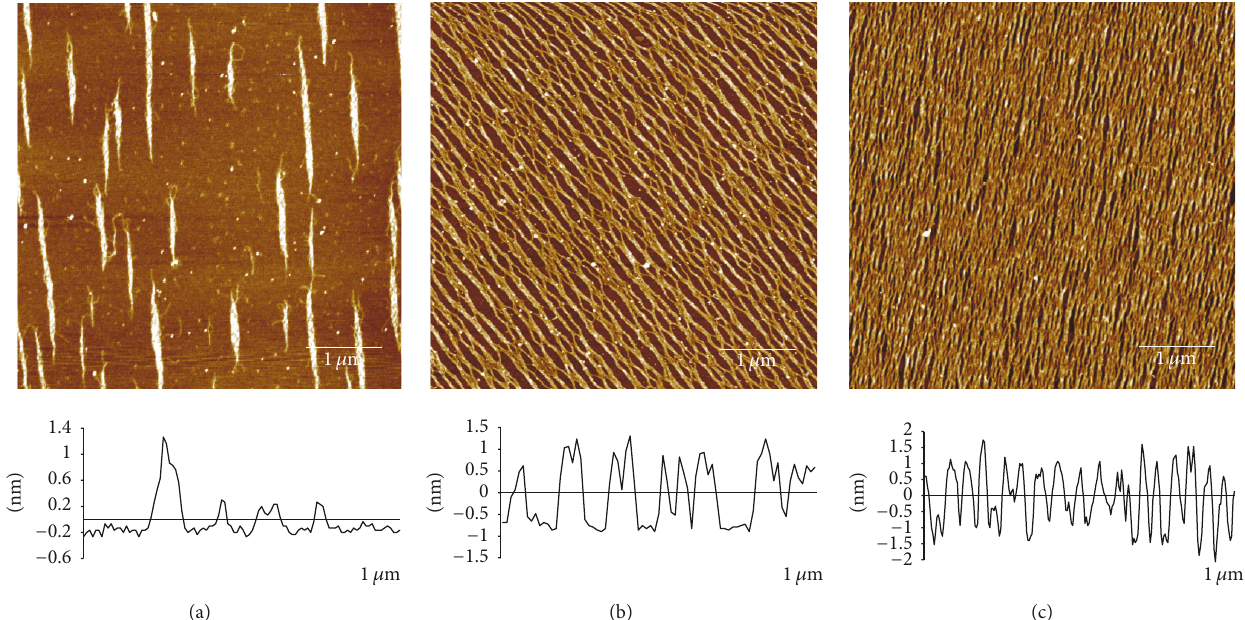
Figure 1: Typical AFM height images and section analysis profiles of collagen self-assembly in different concentrations in 512 × 512 pixels: (a) 0.1mg/ml; (b) 0.2 mg/ml; (c) 0.3 mg/ml.